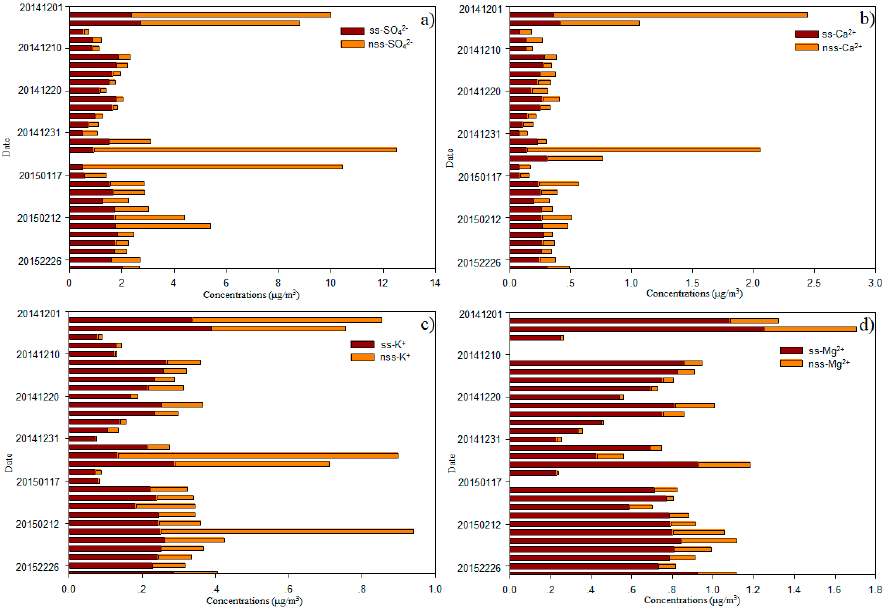
Figure 6. ( a ) nss- and ss-SO 42 − , ( b ) nss- and ss-Ca 2+ , ( c ) nss- and ss-K + , and ( d ) nss- and ss-Mg 2+ at different sites over the western North Pacific.